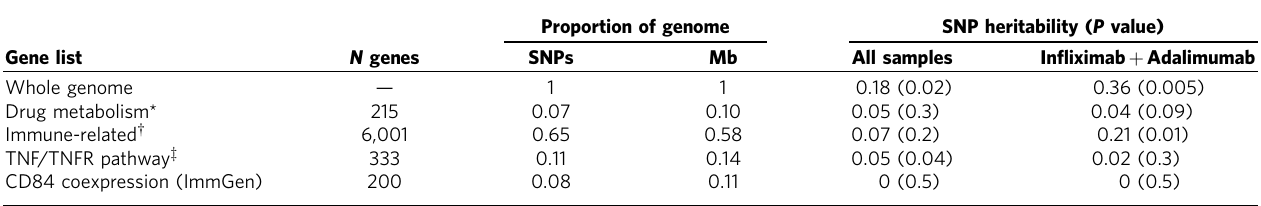
Table 1 | Heritability estimates within the Primary